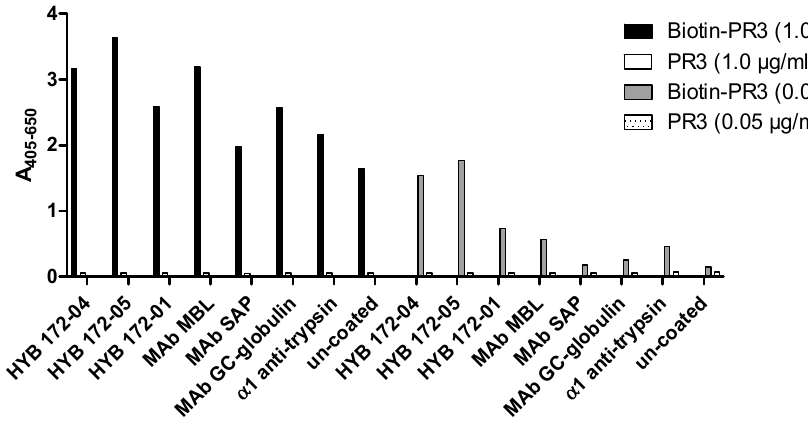
Figure 13. Capture ELISA with coated MAb followed by incubation with biotin-labelled PR3 (SSI) and detection with AP-conjugated streptavidin.